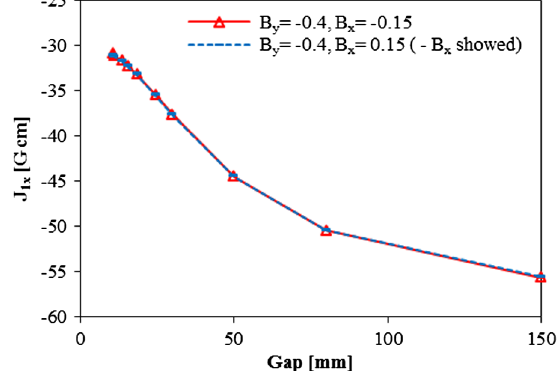
FIG. 8. Comparison of B y ¼ − 0 . 4 , B x ¼ − 0 . 15 and B ¼ − 0 . 4 , B ¼ 0 . 15 gauss for APS27 #5s with frame (R ADIA y x calculations).